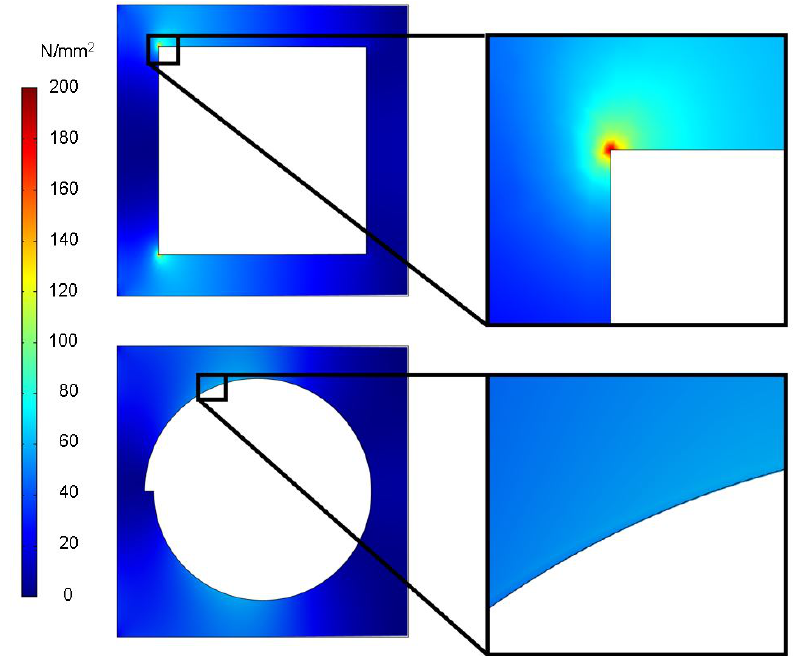
Figure 7. Stress caused by voids in material for different antenna